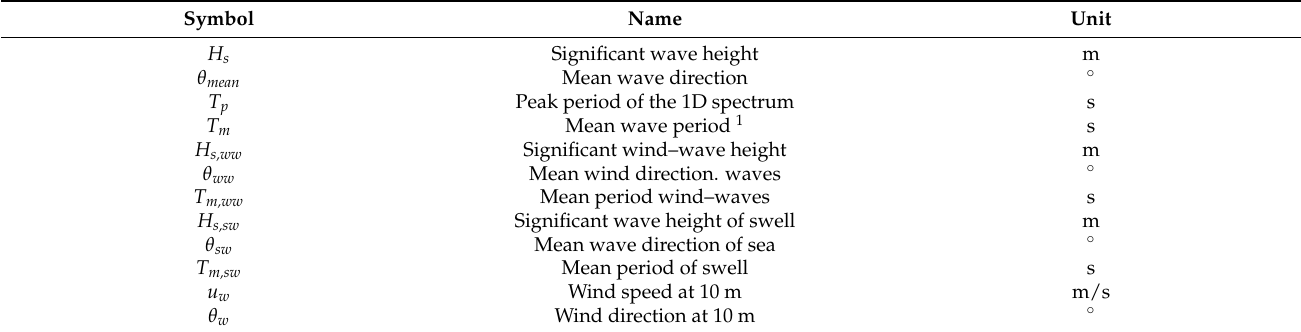
Table A2. Wind and wave parameters available for each location in in the WW